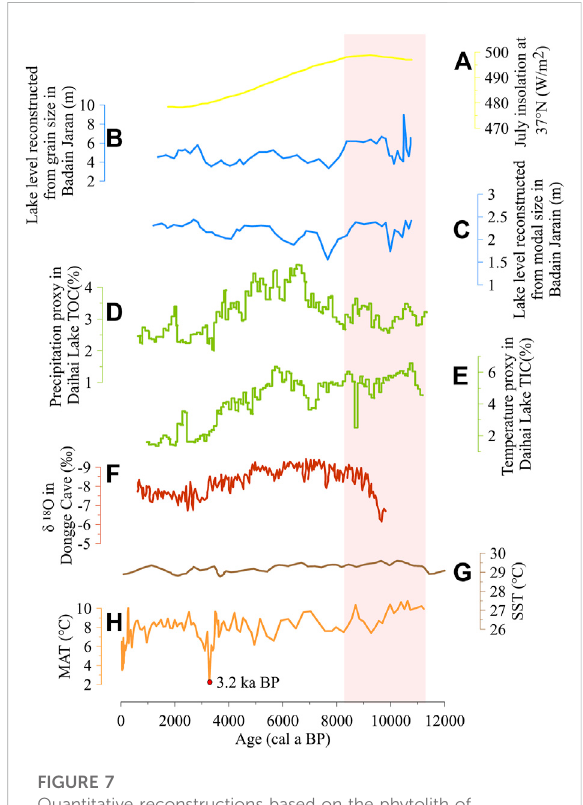
Quantitative reconstructions based on the phytolith of millennial-scale temperature changes in the Badain Jaran Desert during the Holocene and comparison with other Holocene records. (A) July insolation at 37 ° N (Laskar et al., 2004); (B) LakelevelreconstructedfromgrainsizeintheBadainJaranDesert (Dongetal.,2022); (C) Lakelevelreconstructedfrommodalsizein theBadain Jaran Desert (Dong etal., 2022); (D) precipitation proxy in the Daihai Lake (Xiao et al., 2006); (E) temperature proxy in the Daihai Lake (Xiao et al., 2006); (F) δ 18 O in the Dongge Cave, Guizhou Province, China (Dykoski et al., 2005); (G) sea surface temperature(SST)inthewesterntropicalPaci fi c(Stottetal.,2004); (H) the reconstructed temperature in the Badain Jaran Desert (this study). The pink area represents the high paleotemperature in the early Holocene and the red circle represents the 3.2 ka BP